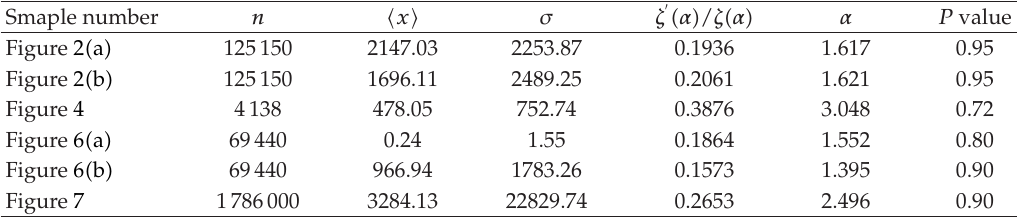
Table 2: Basic parameters of the data sets described in our paper, along with their power-law fits and the corresponding P value. Smaple number Figure 2 (cid:6) a (cid:7) Figure 2 (cid:6) b (cid:7) Figure 4 Figure 6 (cid:6) a (cid:7) Figure 6 (cid:6) b (cid:7) Figure